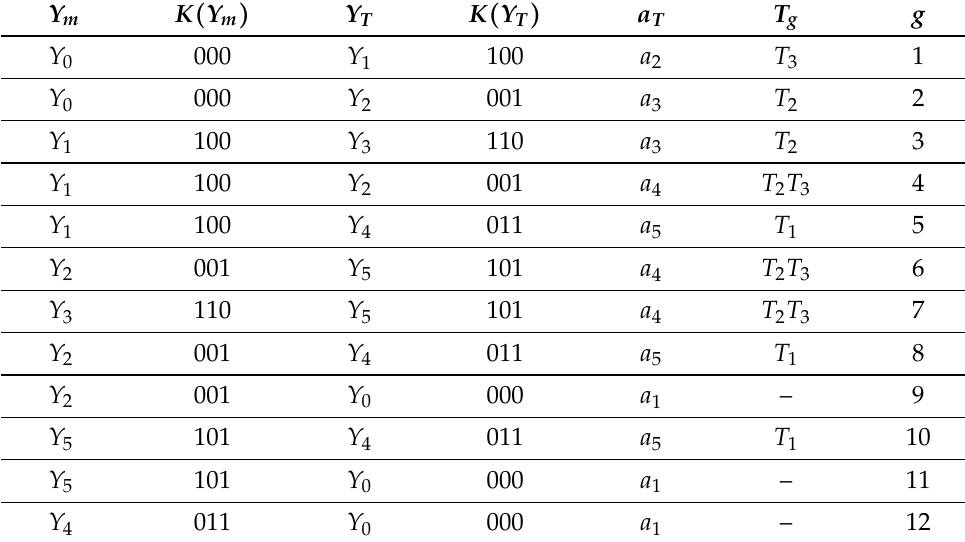
Table 6. Table of block LT of Mealy FSM U 3 ( S 1 )